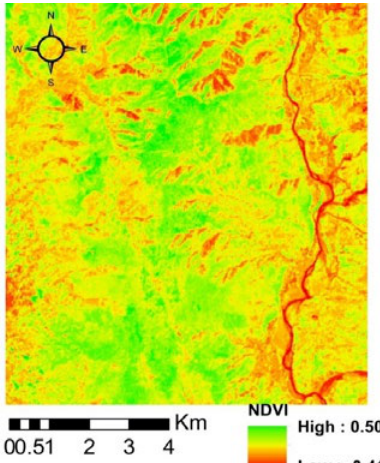
Fig. 2(b). NDVI computed from Fig. 2(a): Scatter plot between AGB and NDVI Fig. 2(b): NDVI computed from Landsat ‐ 8 Image